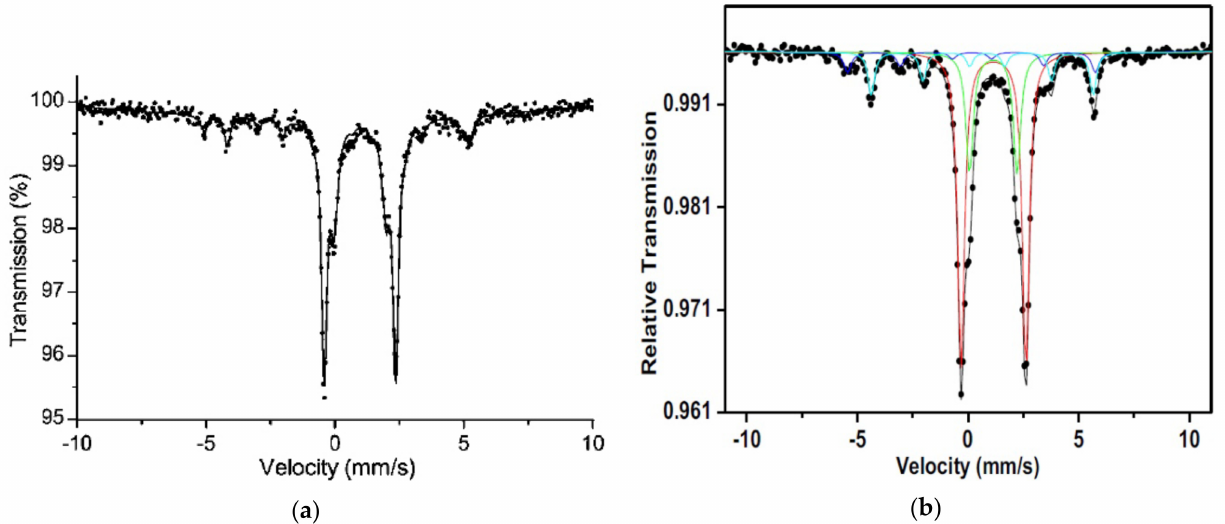
Figure 22. Room temperature Mössbauer spectra of unequilibrated ordinary chondrites Itawa Bhopji L3-5 ( a ) and Aba Panu L3 ( b ). Indicated components are the results of the fits. Adapted from References